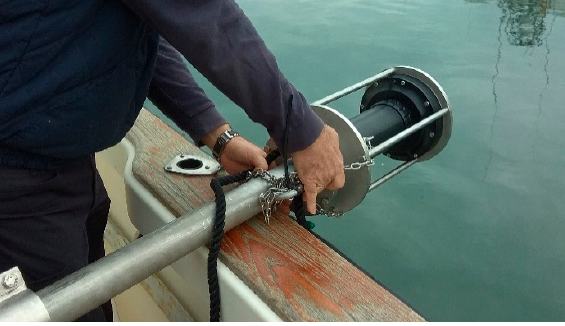
Figure 2. Tooling for joining the echosounder to the side of the boat.